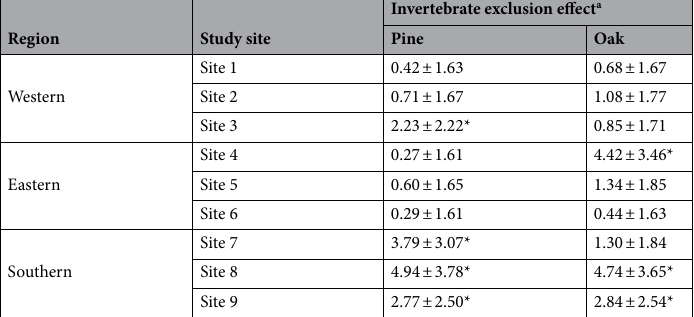
Table 1. The invertebrate exclusion effect and invertebrate damage on deadwood samples in each study site. a Effect size based on Hedges’ d ± 95% confidence interval. Higher value indicates the larger decrease in mass loss of deadwood samples due to the invertebrate exclusion. Values with asterisk are statistically significant at P < 0.05 (the 95% confidence interval did not overlap with zero).